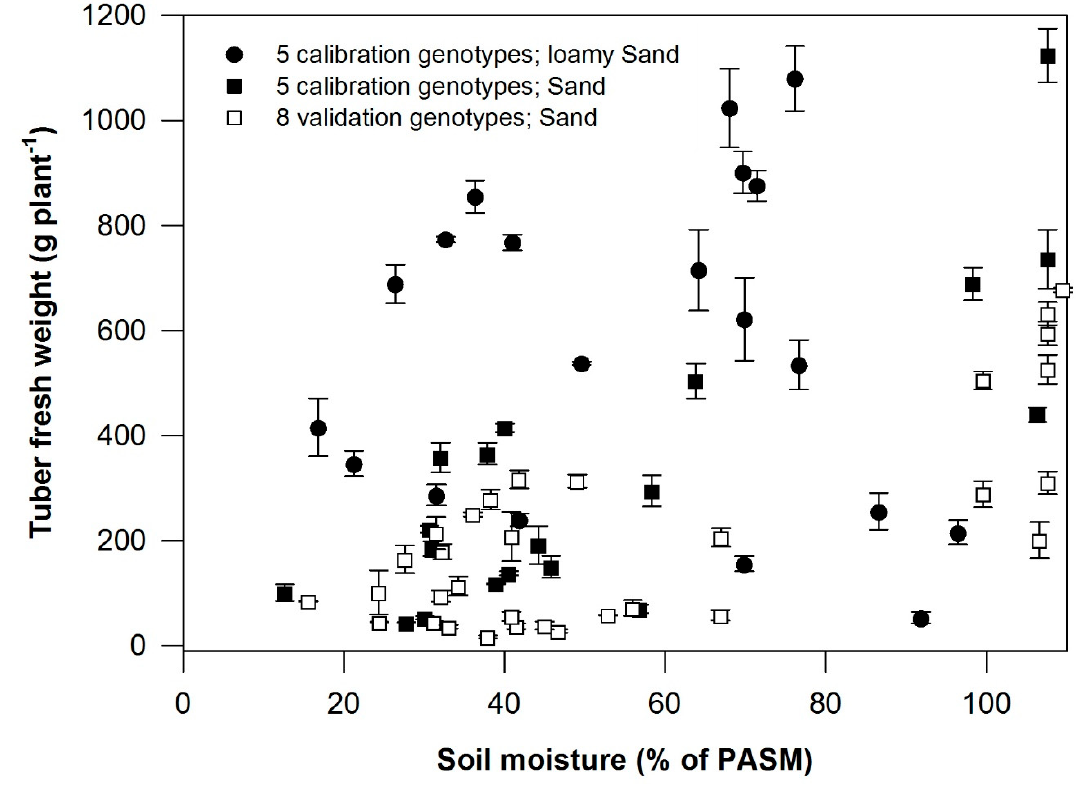
Figure 3. Effects of reduced plant available soil moisture (PASM) on tuber yield of all genotypes under the four applied irrigation treatments for both soil types. Calibration genotypes were employed to develop the stress severity index; validation genotypes were used to apply and analyze the stress severity index. The percent of PASM values above 100 indicate irrigation over the irrigation target due to variations in the drip system.